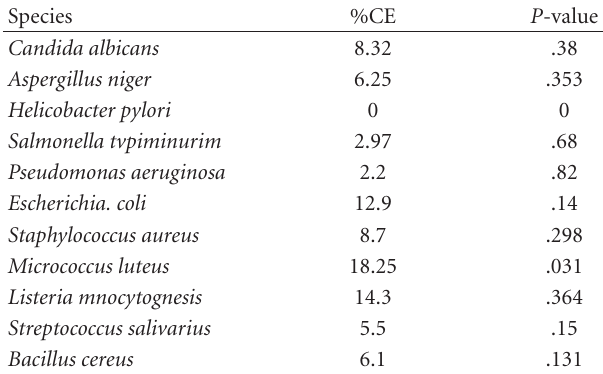
Table 2: Results of the antimicrobial tests on the THF